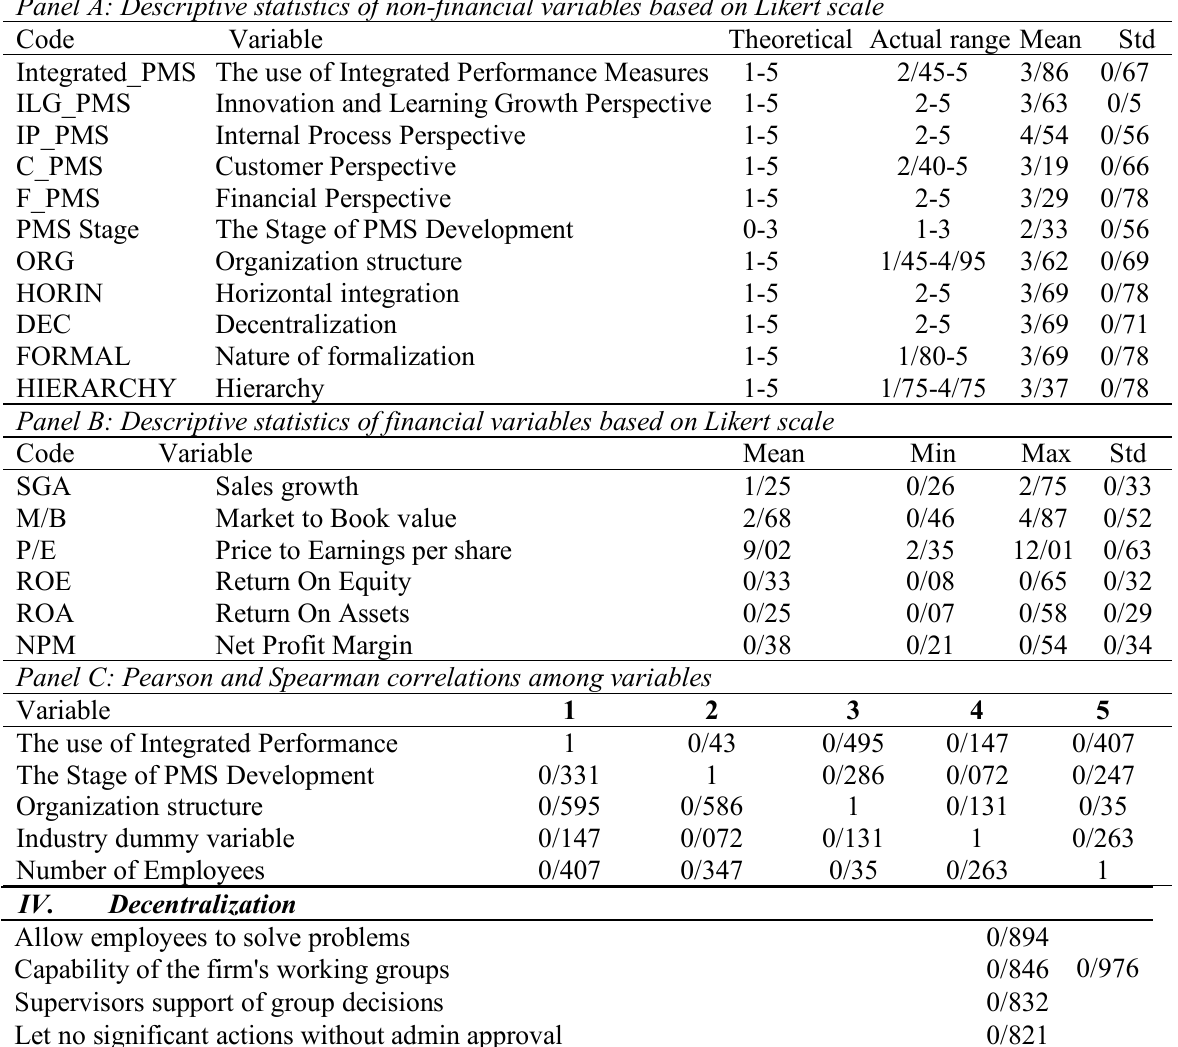
Table 5 . Descriptive Statistics and correlations among variables (N= 127) Panel A: Descriptive statistics of non-financial variables based on Likert scale